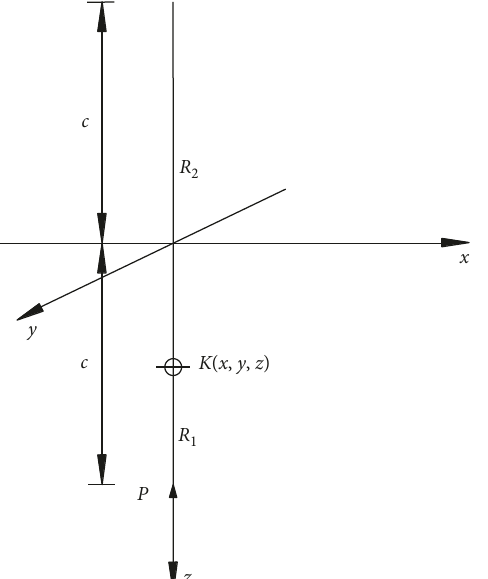
Figure 15: Schematic diagram of the calculation model under the condition.